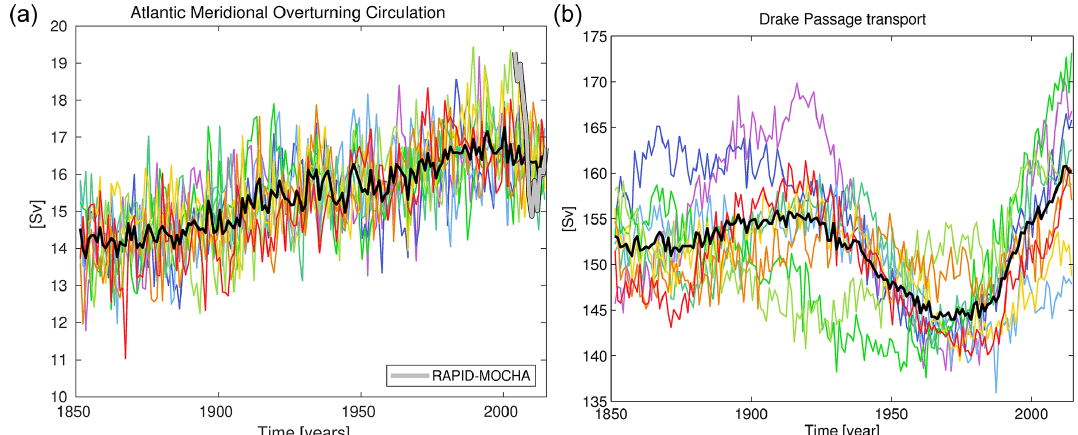
Figure 9. Time series plots of the ocean circulation during the historical period from 1850 to 2015. Panels show annual averages of AMOC (a) and Drake Passage (b) transport for all nine ensemble members (coloured lines) and the ensemble mean (solid black line). Observational data of AMOC transport from the RAPID-MOCHA array is shown in grey for the period 2003–2015. For additional clarity, Fig. S8 in the Supplement re-plots this panel to focus on this recent period.